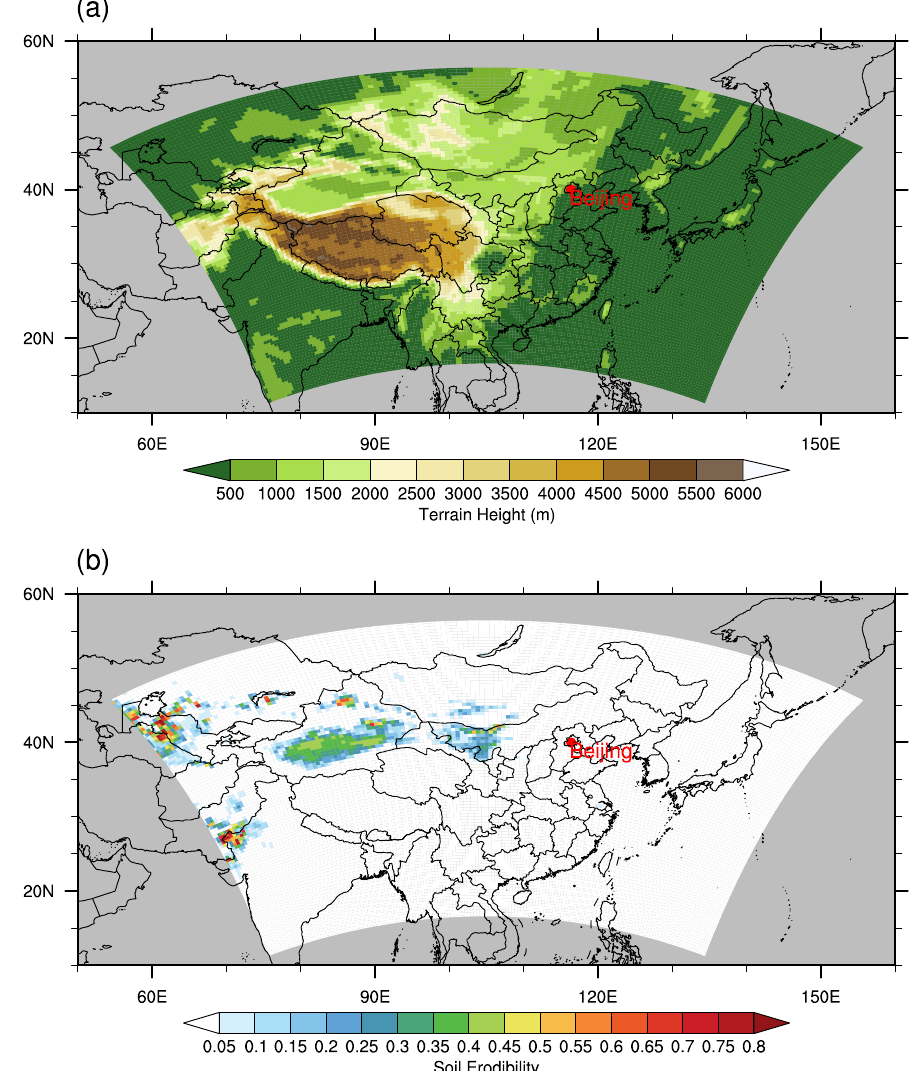
Figure 2. Model simulation domain with ( a ) the terrain height and ( b ) soil erodibility. The soil erodibility ranges from 0 to 1, with 0 indicating no erodibility (i.e., no dust source). The pink dot depicts the location of the Beijing site of Aerosol Robotic Network (AERONET) used for independent validation.